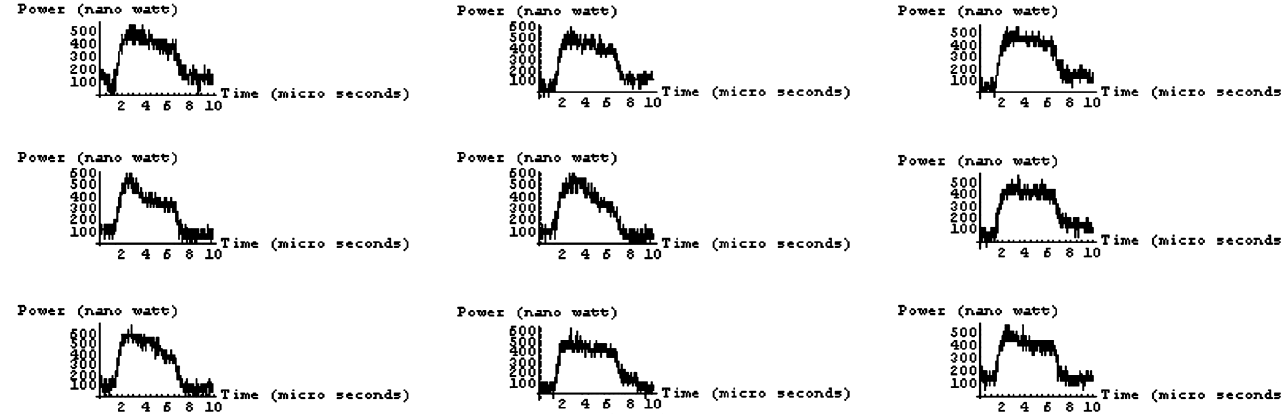
FIG. 4. A few of the pulse